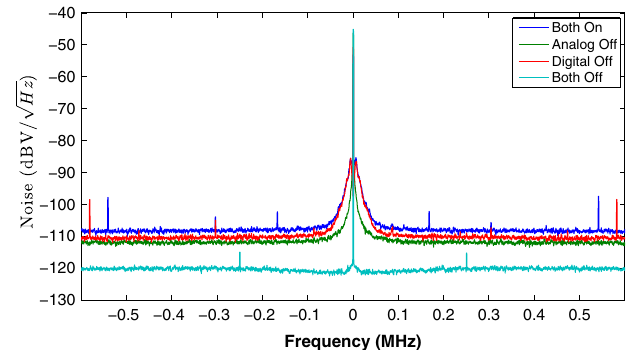
FIG. 15. Noise PSD at the rf feedback output with different switch positions. The rf input is terminated.